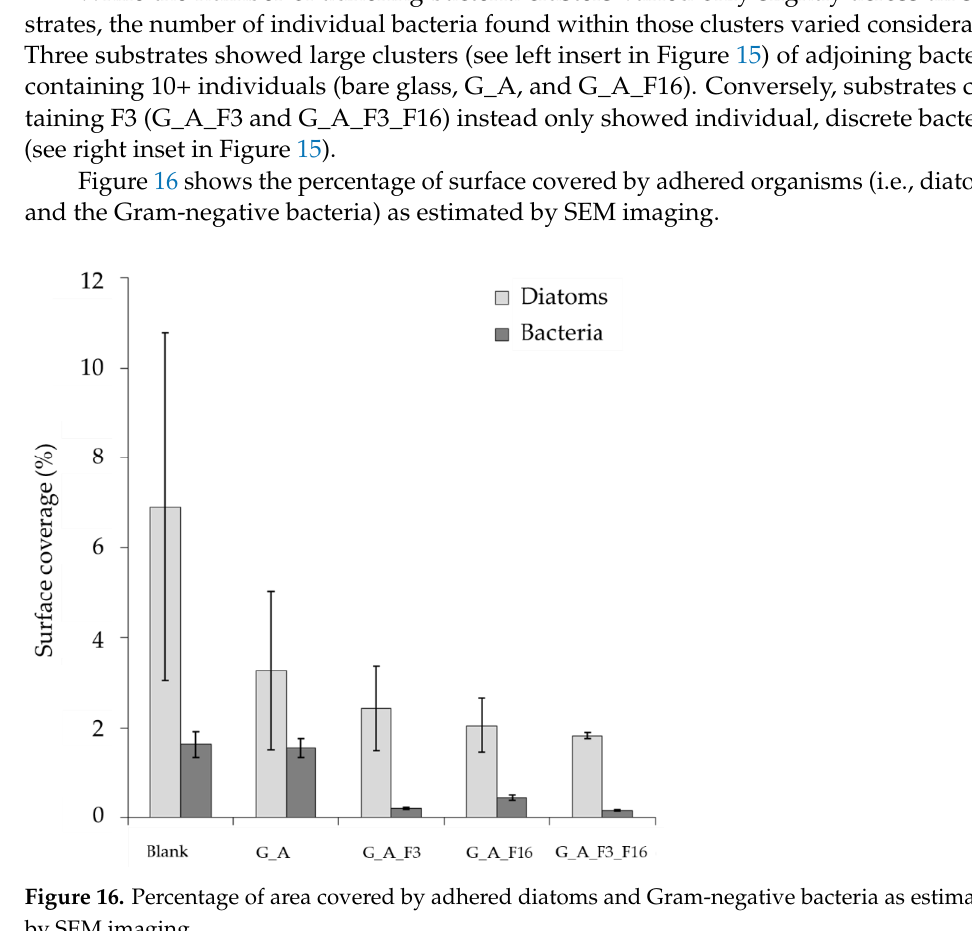
Figure 17. Histogram showing the increase in OD 550 of the bacterial suspensions before the experi- ment and after. No significant differences were found between the control suspensions (no glasses, T 24S, and untreated glasses T 24C ) and the microbial suspensions coming from the Petri dishes with treated glasses.